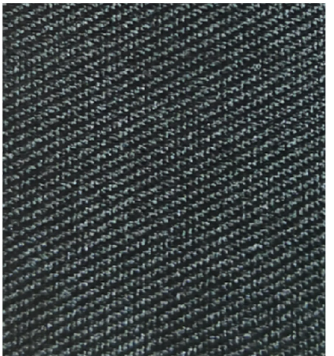
Figure 2. All-polyester woven fabric.